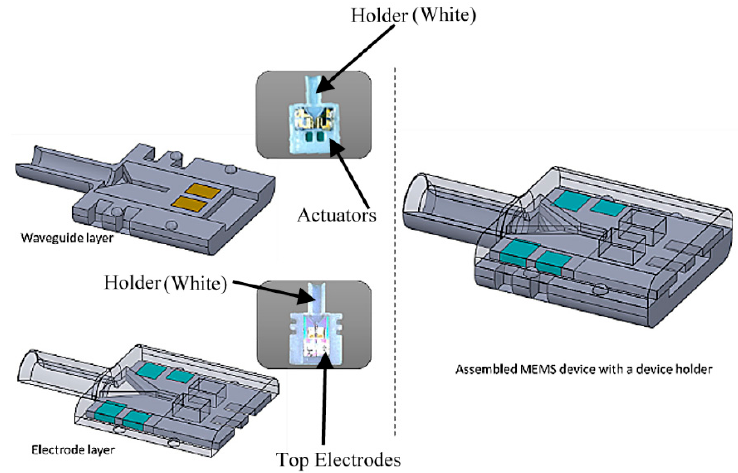
Figure 14. Schematics of assembled MEMS device, including top electrode, scanner, bottom electrodes, and gradient index (GRIN) lens with the device holder.